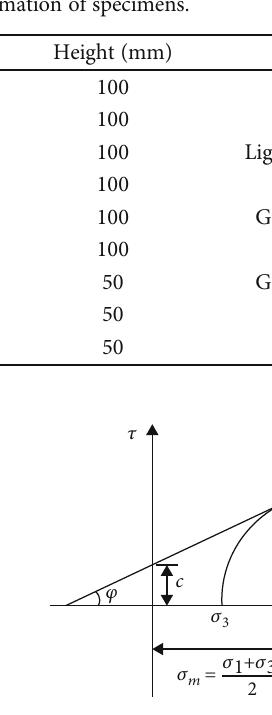
Figure 3: Mohr-Coulomb failure